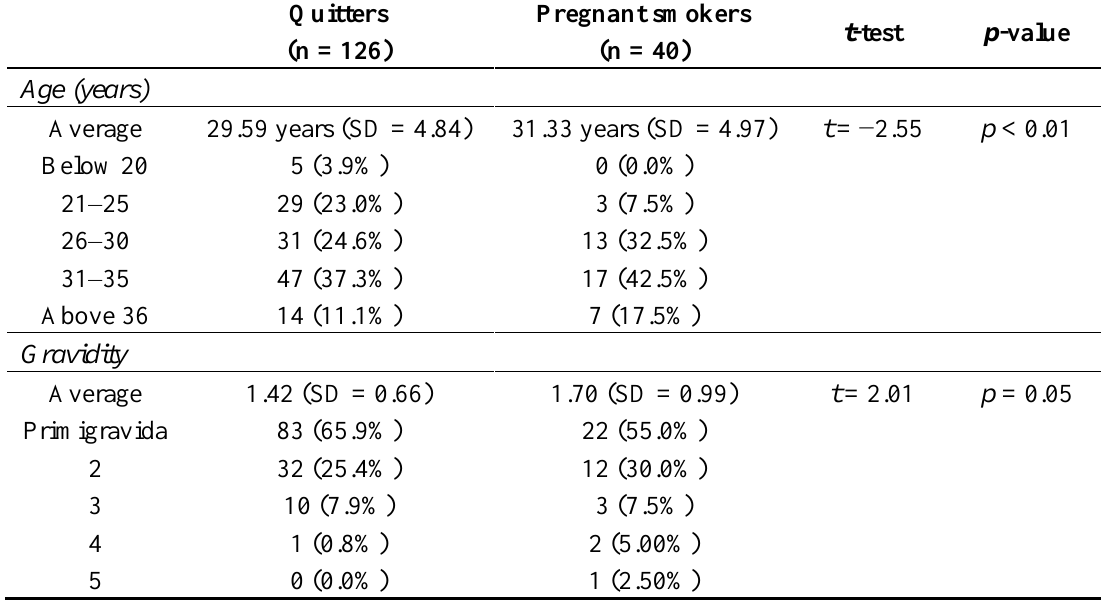
Table 1. Demographic profile of participants and their smoking behavior.